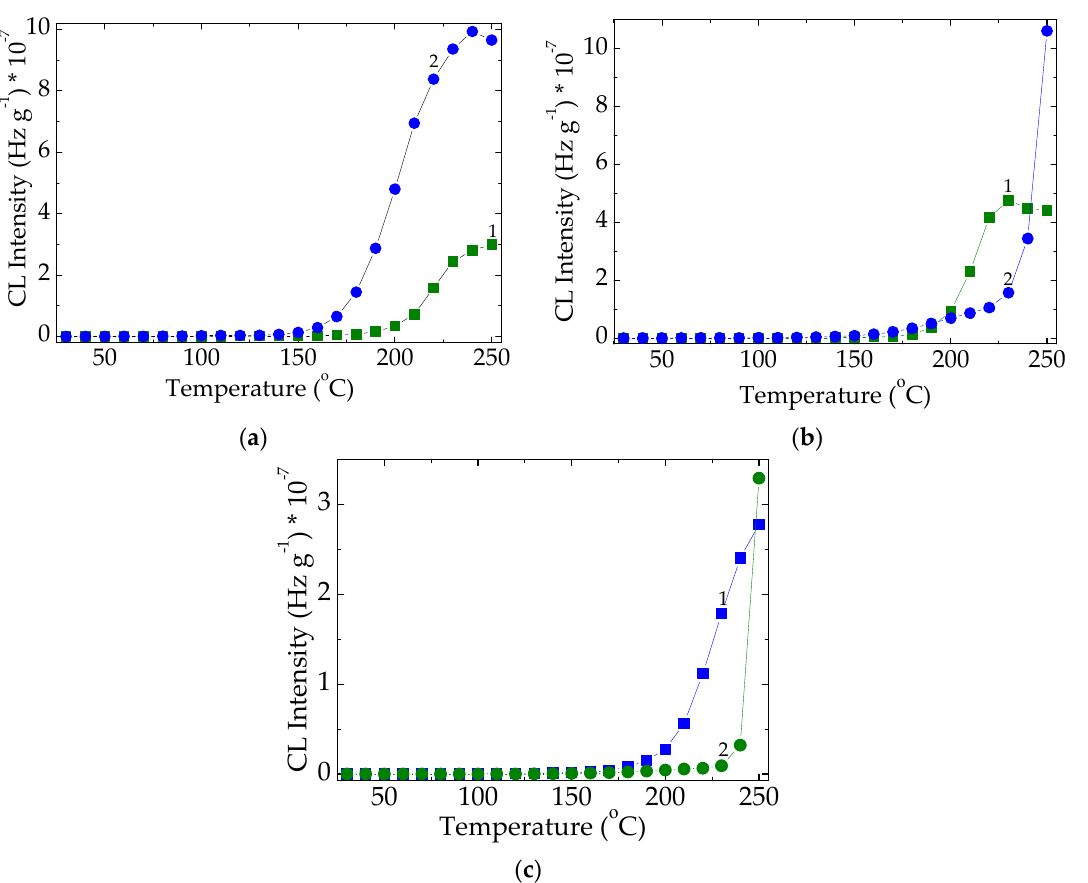
Figure 8. The nonisothermal CL spectra of powder and PP hybrid modified with the same filler in the unirradiated states. Heating rate; 10 °C min − 1 . ( a ) P3; ( b ) P1; ( c ) P 2. (1) hybrid; (2) powder.